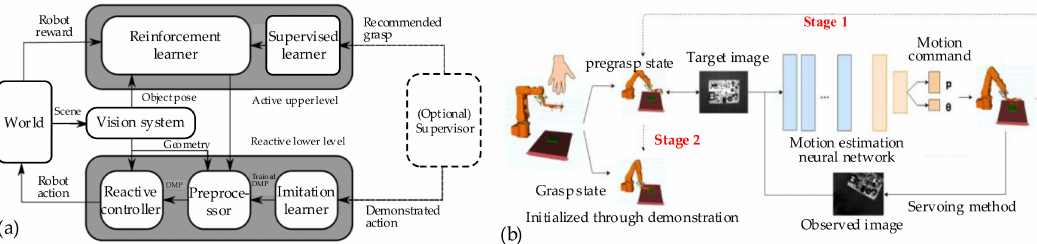
Figure 14. A priori experience-based grasping approaches: ( a ) the hierarchical controller architecture [122], ( b ) the active learning architecture